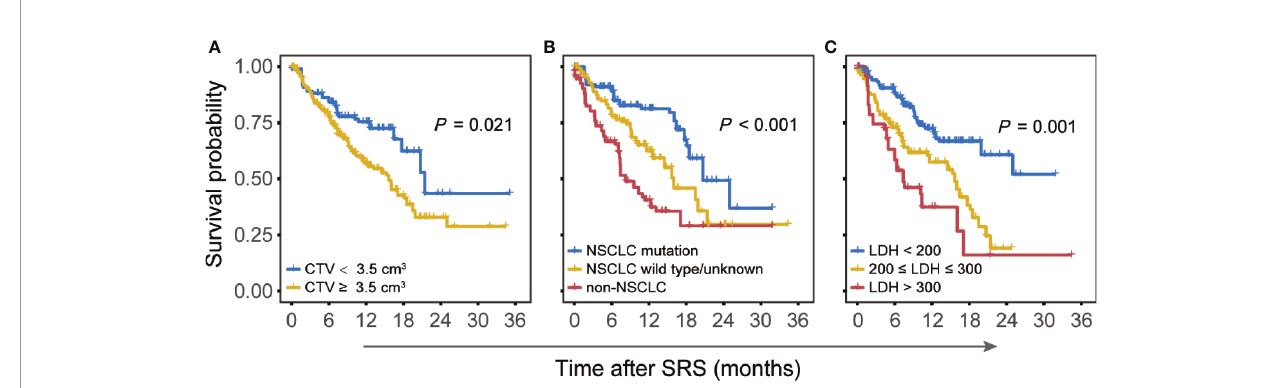
FIGURE 1 | Kaplan – Meier curves for overall survival after stereotactic radiosurgery (SRS) in patients with brain metastases (BM) with reference to (A) cumulative tumor volume (CTV), (B) primary tumor type (mutation status), and (C) serum lactate dehydrogenase (LDH)